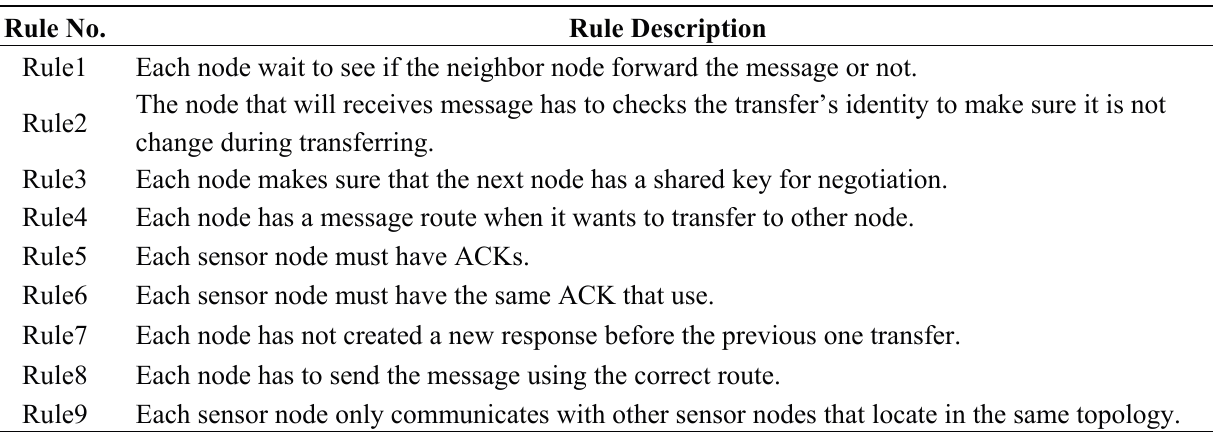
Table 1. Rules based in selective forwarding